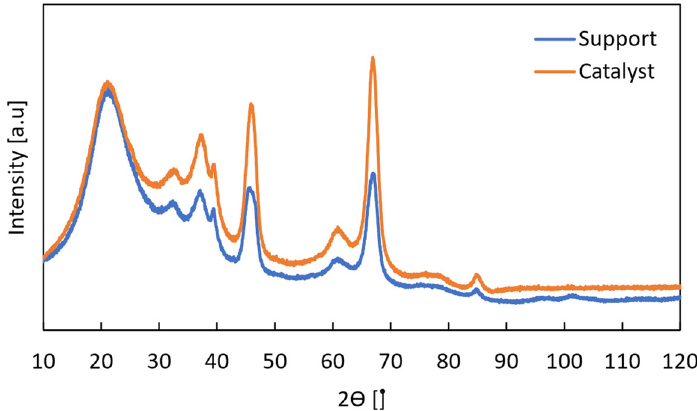
Figure A3. TPR signal obtained via TPR analysis of the fresh Pt-Sn-K/Al 2 O 3 catalyst used in this work.